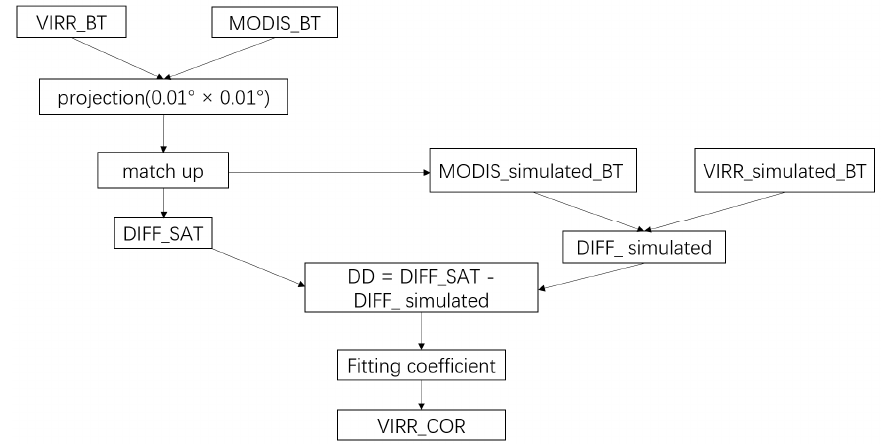
Figure 1. Inter-calibration process of VIRR_BT and MODIS_BT.